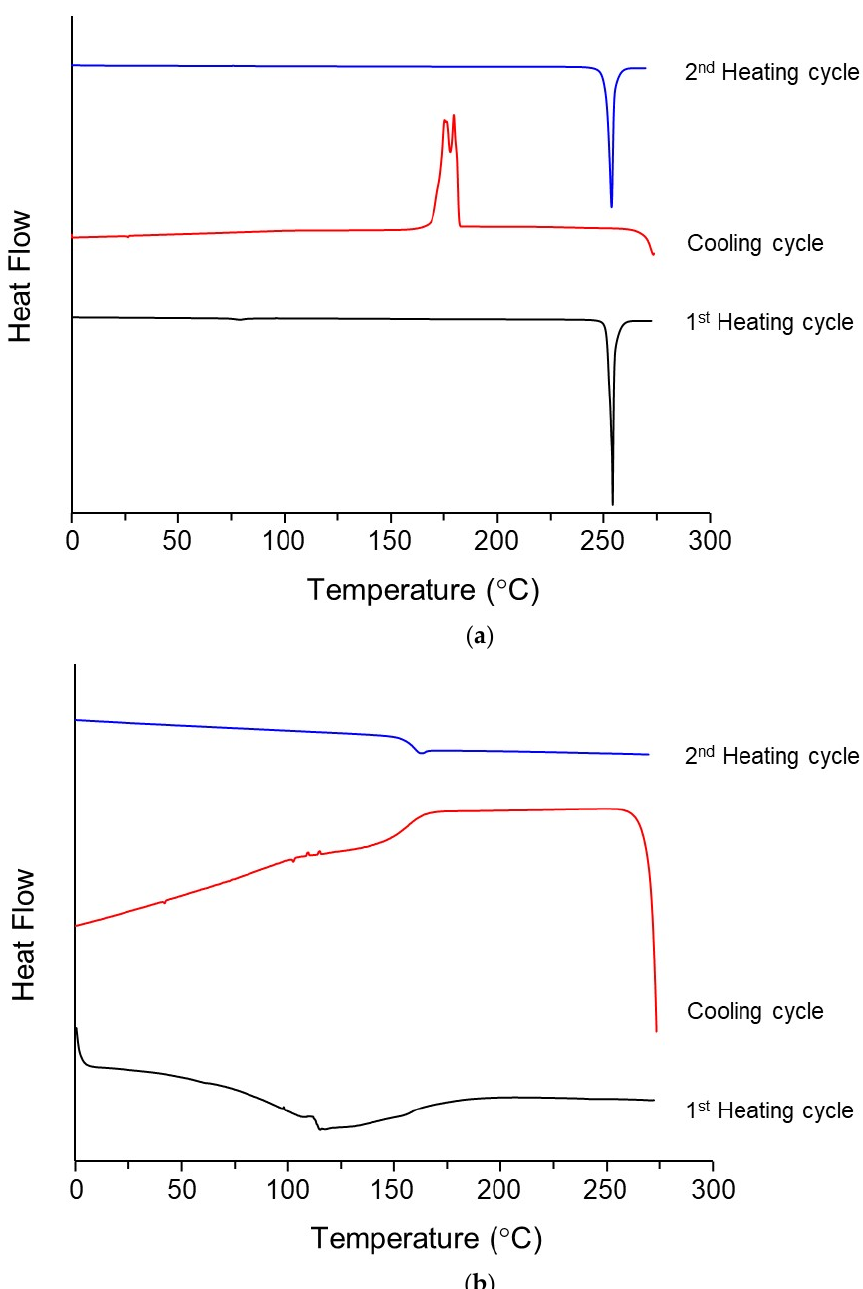
Figure 3. Typical DSC profiles of 1st heating, cooling and 2nd heating cycle for ( a ) AntiY 5 R and ( b ) NaTC. Table 2. Thermal properties obtained by DSC analysis for AntiY 5 R and NaTC.